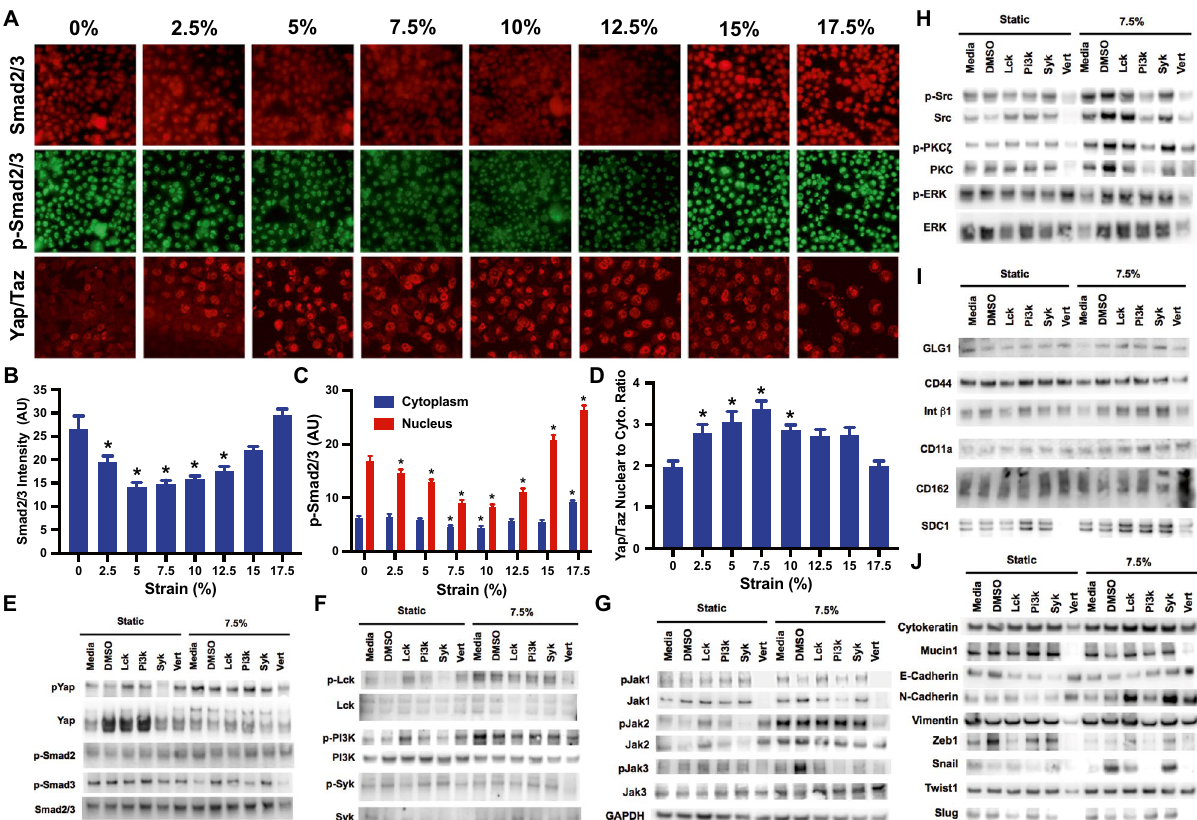
Figure 5. Strain differentially activates Smad2/3 and Yap/Taz in breast cancer and epithelial cells. ( A ) MDA-MB-231 cells were treated with mechanical strain for 24 h at 1 Hz with varying magnitudes of maximal strain. Immunostaining for phospho-Smad2/3, Smad2/3 and Yap/Taz was performed. Bar = 100 μm. ( B ) Quantification of total Smad2/3 in the cells (n = 20). * p < 0.05 versus static group (n = 20). ( C ) Quantification of phosphorylated Smad2/3 in cells treated mechanical load (n = 20). * p < 0.05 versus the static group for the same subcellular location. ( D ) Quantification of nuclear to cytoplasmic Yap/Taz staining (n = 20). * p < 0.05 versus static group. (E-J) Western blotting for lysates from cells treated with mechanical load for 24 h and inhibitors Lck, PI3K, Syk and Yap (Vert; verteporfin). Full-length blots/gels are presented in Supplemental Figs.